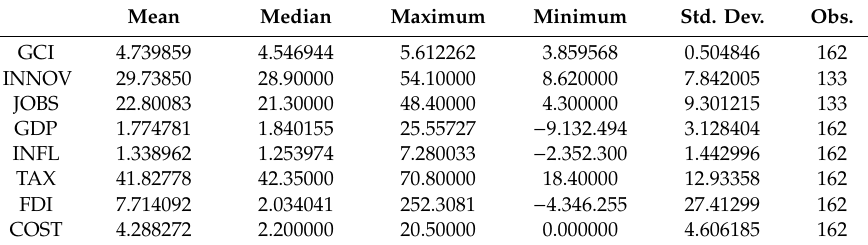
Table 3. Descriptive statistics of dependent and explanatory